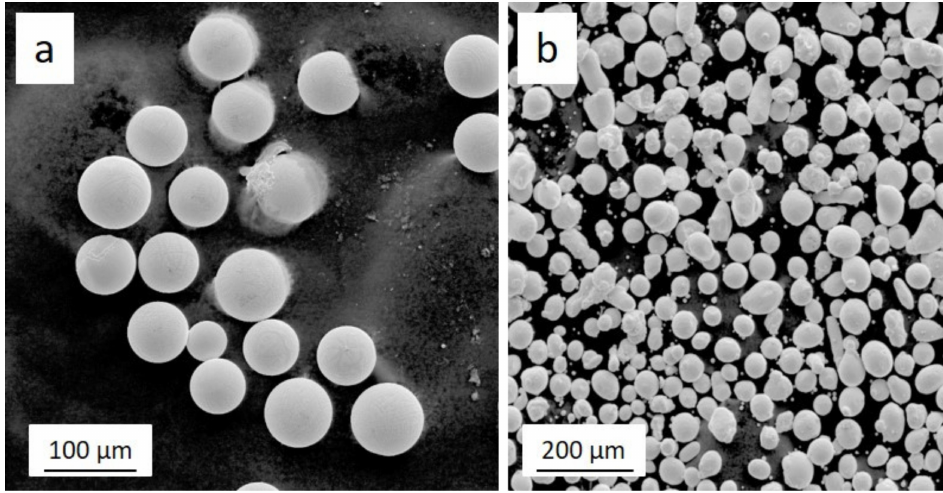
Figure 5. The morphology of HN71MTYuB ( a ) and PR-12H18N9T ( b ) powder